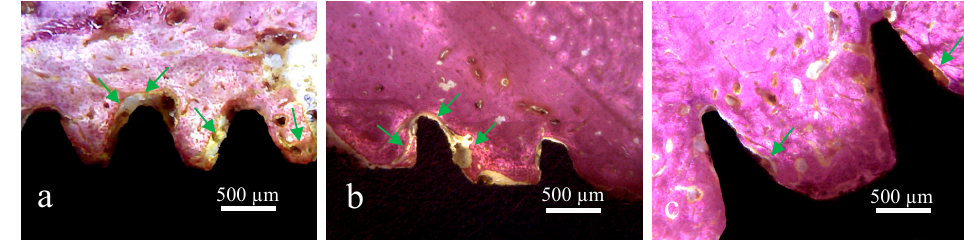
Figure 7. Representative histological images of samples: ( a ) Group 1, ( b ) Group 2, and ( c ) Group 3. The space between the lines showed the different amount of bone reaction (stimulation) from the implant body (green line) to the native bone tissue (yellow line) of each group. Detailed observation of the bone in proximity to the V threads (G1) and squared threads (G2) revealed bone tissue with more collagen areas compared to bone inside the healing chambers of the G3 implants (Figure 8).